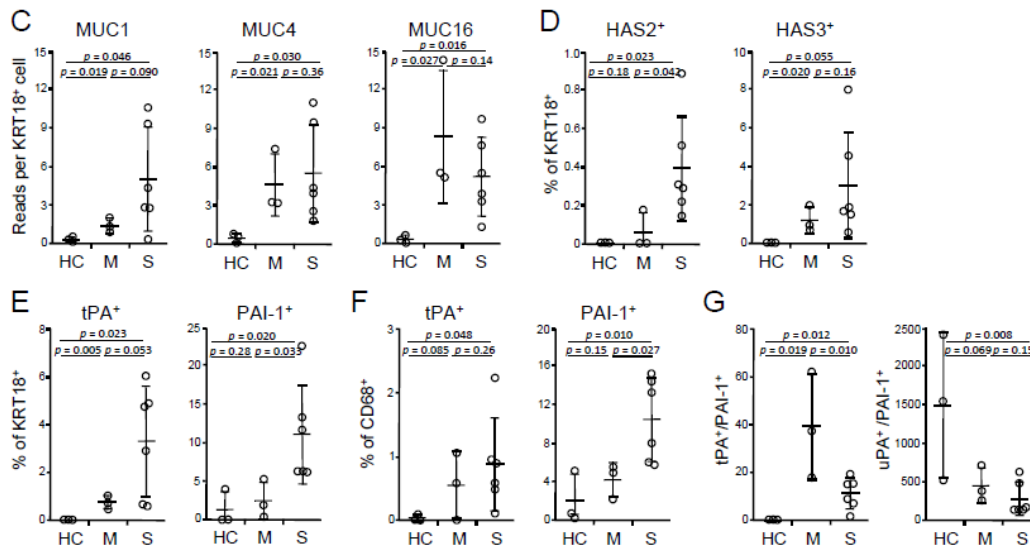
Figure 2. Expression of tissue factors in BALF cells. ( A , B ) Frequencies of MMP- and TIMP-expressing epithelial cells ( A ) and macrophages ( B ). ( C ) Abundances of MUCs in epithelial cells. ( D ) Frequencies of HAS-expressing epithelial cells. ( E , F ) Frequencies of tPA- and PAI-1-expressing epithelial cells ( E ) and macrophages ( F ). ( G ) Ratios of total tPA vs. PAI-1 and total uPA- vs. PAI-1-expressing cells. HC, healthy control ( n = 3); M, mild ( n = 3); S, severe ( n = 6). Mean and s.d. are shown; p values; unpaired t -test.